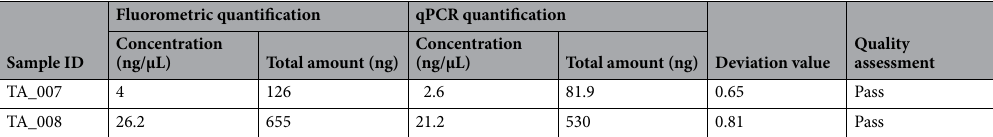
Table 4. Quality assessment of divided samples with trimming for gene panel testing. qPCR = quantitative polymerase chain reaction.